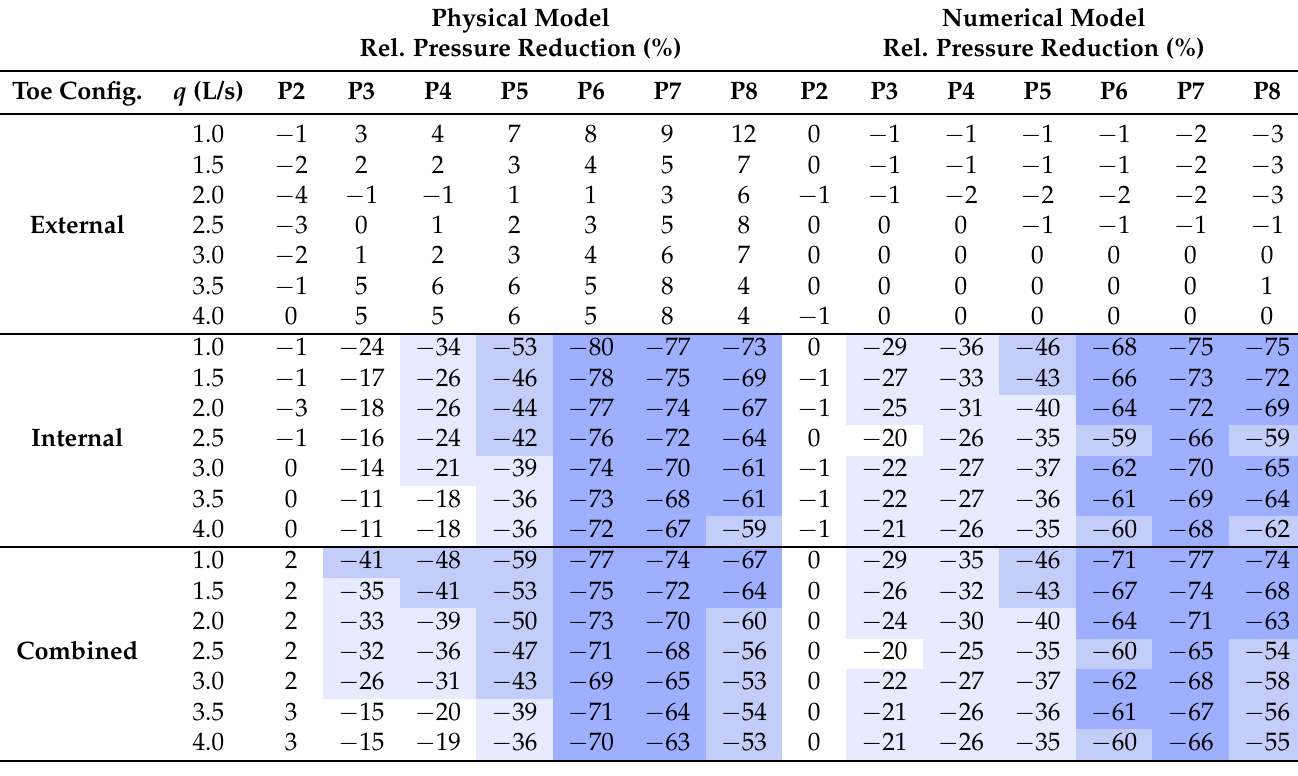
Table 4. Comparison of pressure reduction for different toe configurations relative to no toe configuration for physical and numerical